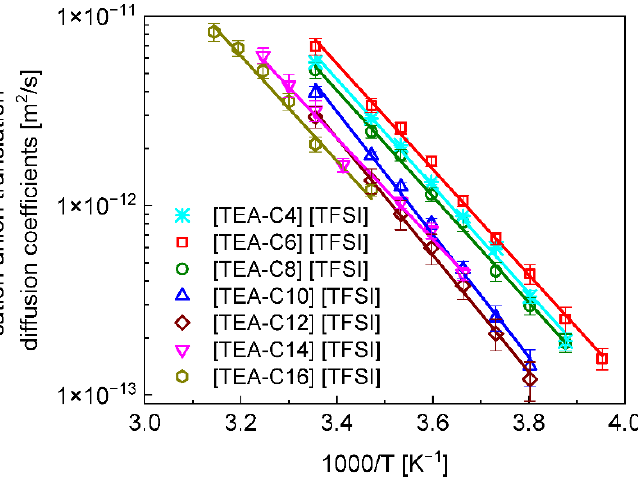
Figure 3. Relative cation–anion translation diffusion coefficients, D CA